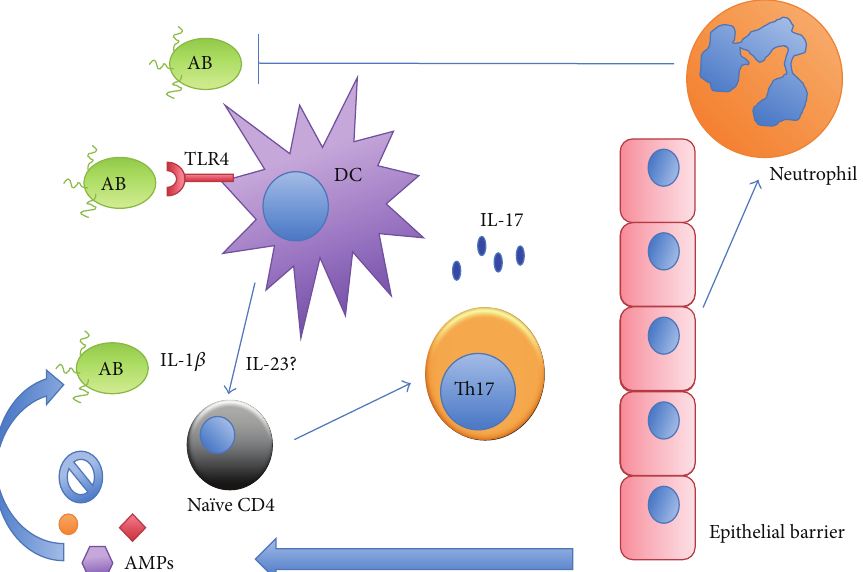
Figure 1: Potential role of Th17 cells in A. baumannii (AB) infection. As depicted above, TLR ligands of AB can activate TLRs on DCs and/or macrophages from the host and provoke the release of proinflammatory cytokines such as IL-1 𝛽 and possibly IL-23. Na¨ıve CD4 T cells differentiate into effector Th17 cells and produce Th17 signature cytokines. These cytokines include IL-17 signal epithelial cells at barrier tissues and exert antimicrobial function through 2 possible mechanisms: recruiting neutrophils and antimicrobial